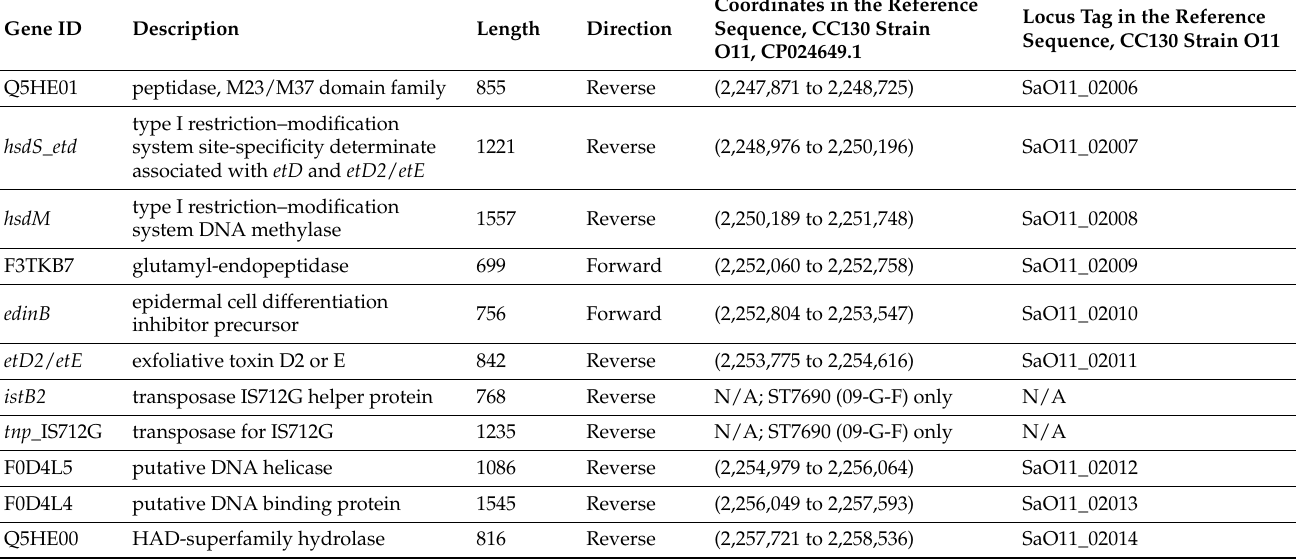
Table 3. The pathogenicity island carrying edinB and etD2 / etE (see also Figure